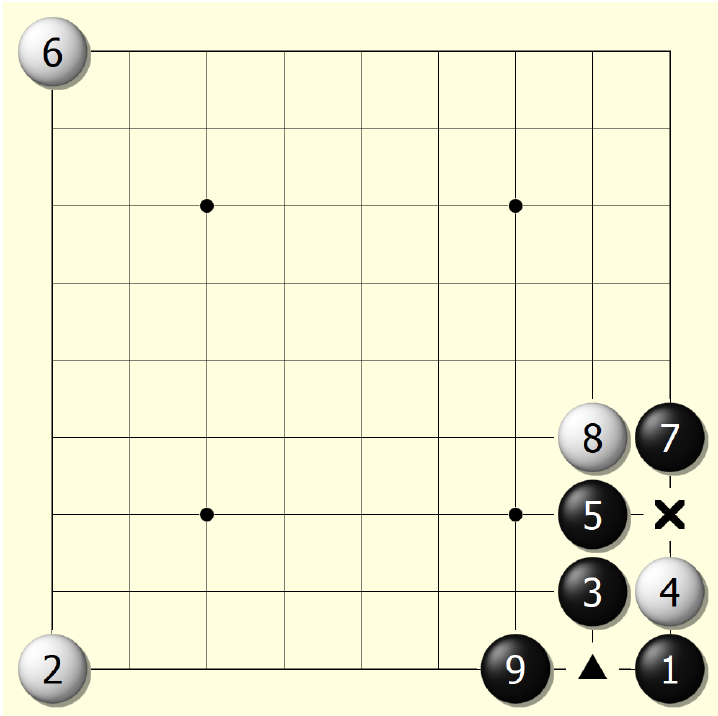
Figure 7. Demonstration of ‘triangle strategy’. Black successfully built a triangle structure in the location marked by (cid:52) , and white successfully prevented black from building triangle structure in Step 4 because neither black nor white could occupy the location marked by ×. Moreover, the white stone placed in Step 8 also tried to destroy a potential triangle structure that may have contained the black stones placed in Steps 5 and